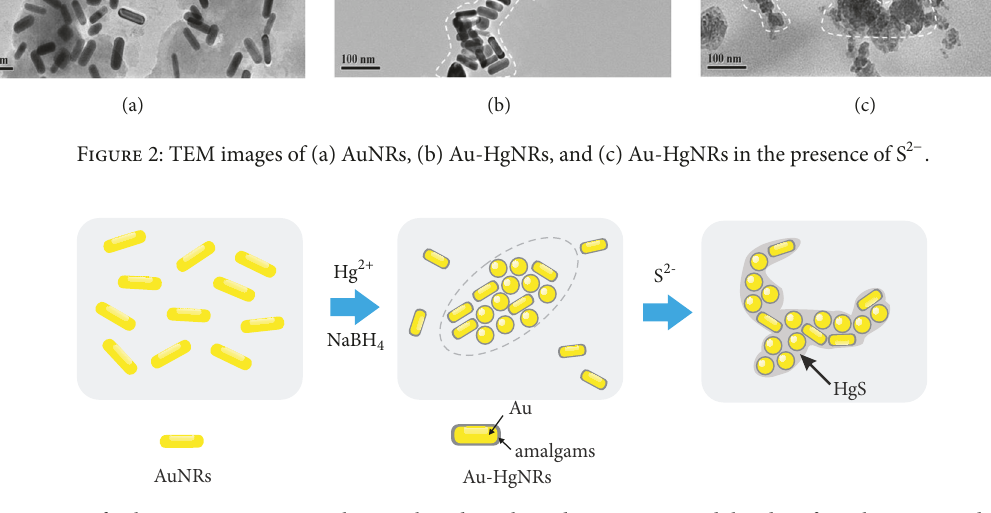
Scheme 1: Illustration of colorimetric sensing mechanism based on the redox reaction modulated surface chemistry and morphology of Au-HgNRs nanorods.